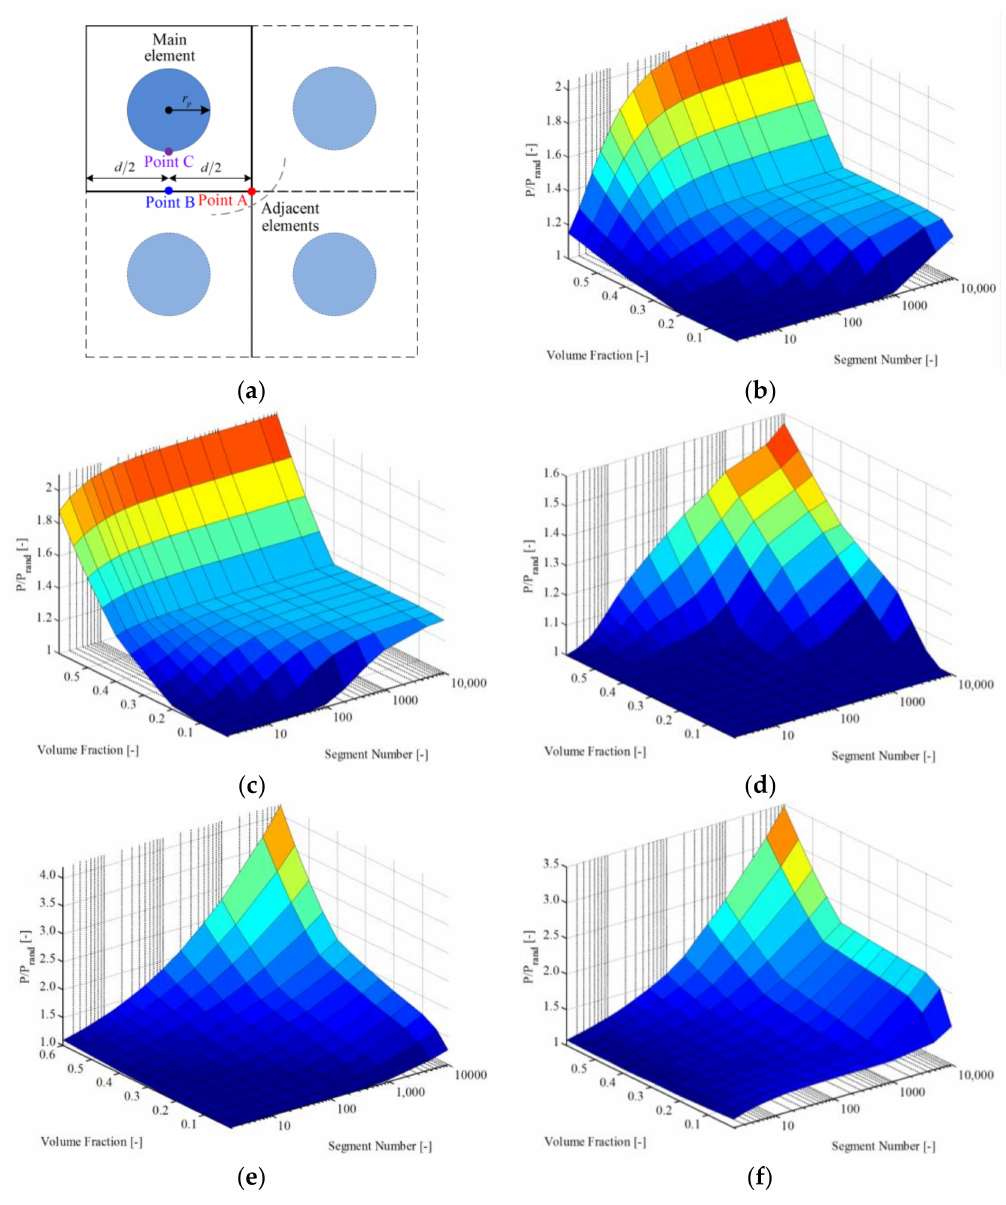
Figure 13. Density of polymer chain: ( a ) representative volume element; ( b ) point A- r p / l = 10, k = 1; ( c ) point A- r p / l = 10, k = 10; ( d ) point A- r p / l = 100, k = 1; ( e ) point B- r p / l = 10, k = 1; ( f ) point C- r p / l = 10, k =